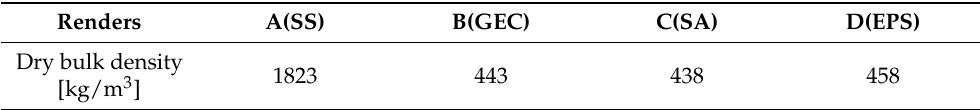
Table 2. Dry bulk density of the renders at hardened